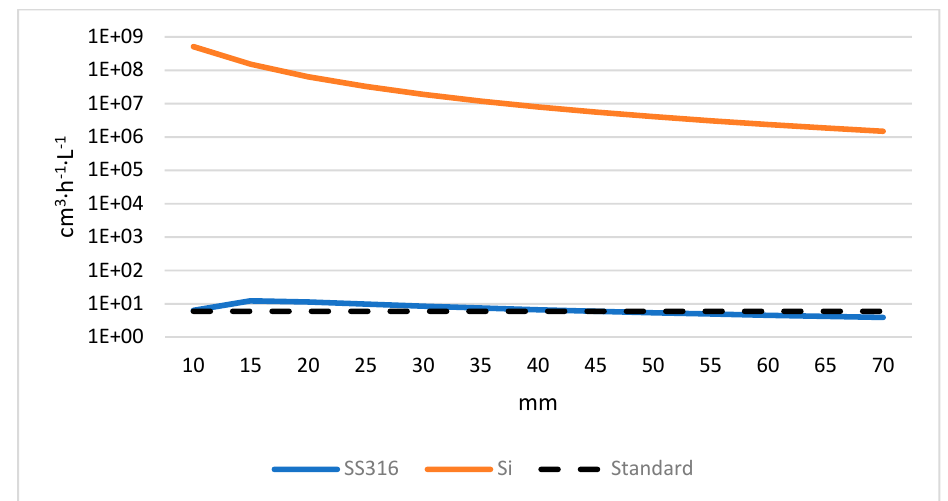
Figure 10. Permeation for spheres made of CFEP, equipped with a microchip, made of either SS316 or Si, for ID from 10 to 70 mm, at 700 daN cm − 2 of inside pressure.